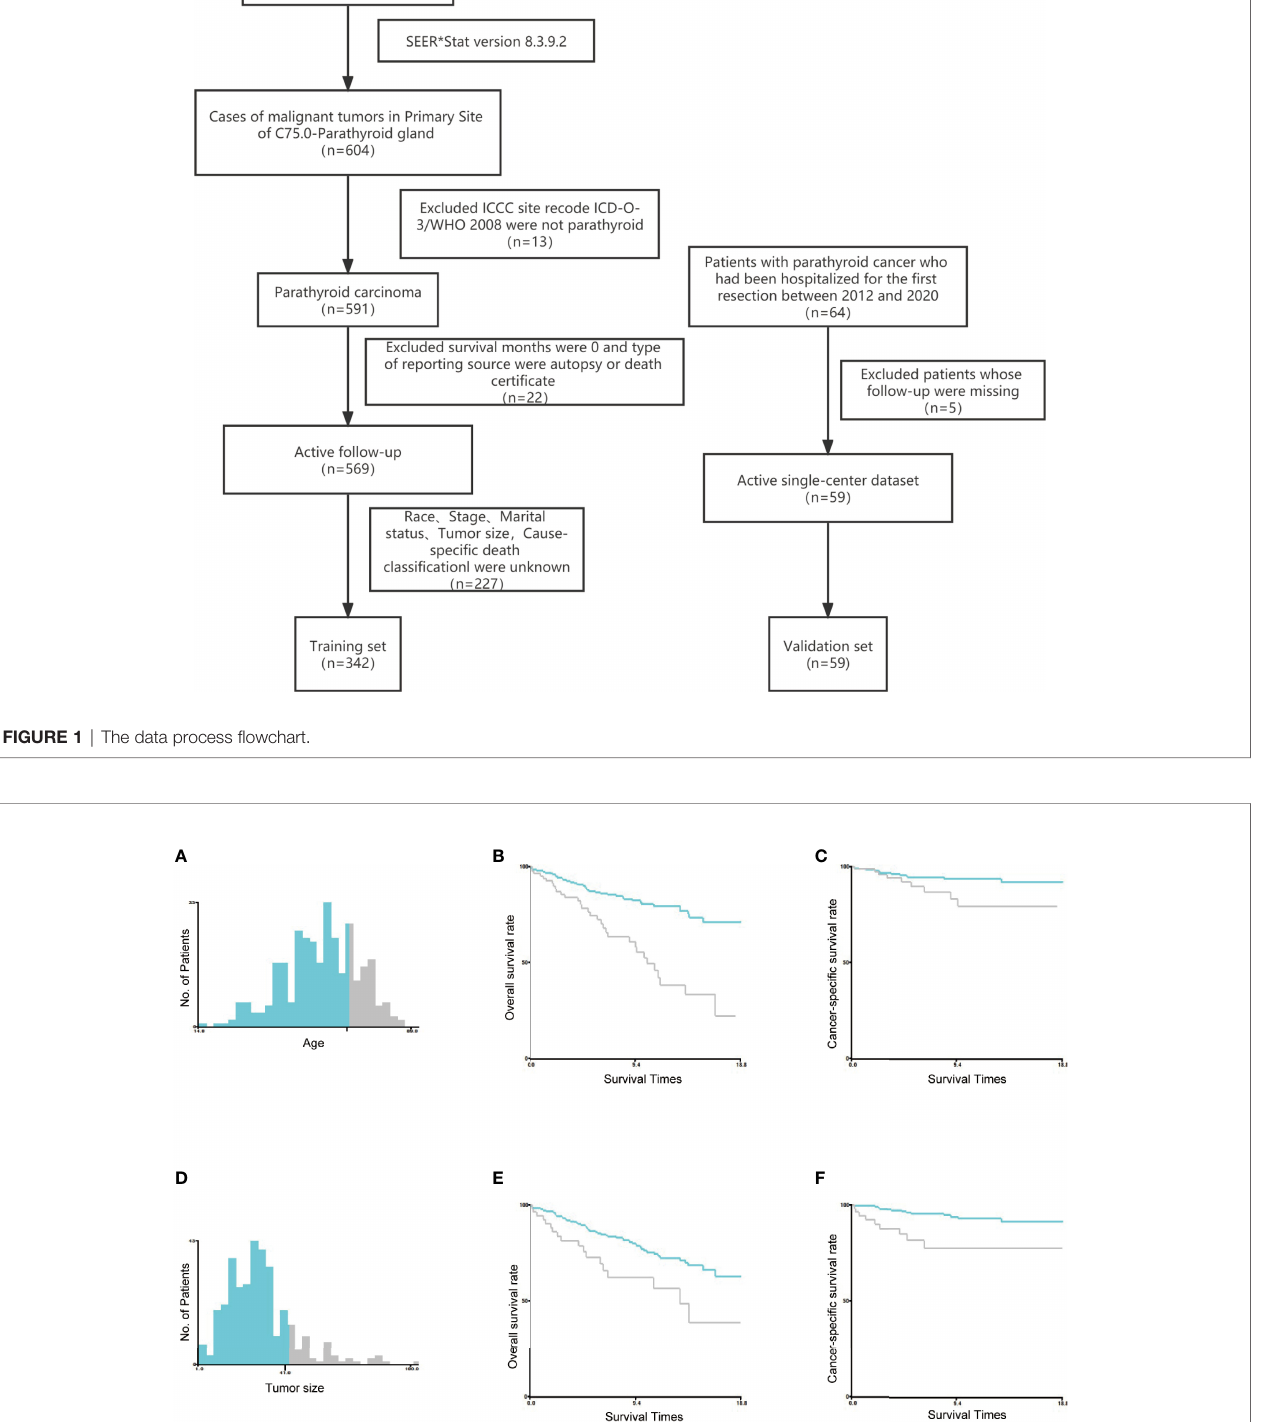
FIGURE 2 | Identi fi cation of the optimal cutoff values of age and tumor size. The optimal cutoff values of age were identi fi ed as 66 years based on both overall survival and cancer-speci fi c survival (A – C) . The optimal cutoff value of tumor size was identi fi ed as 41 mm based on both overall survival and cancer-speci fi c survival (D – F)